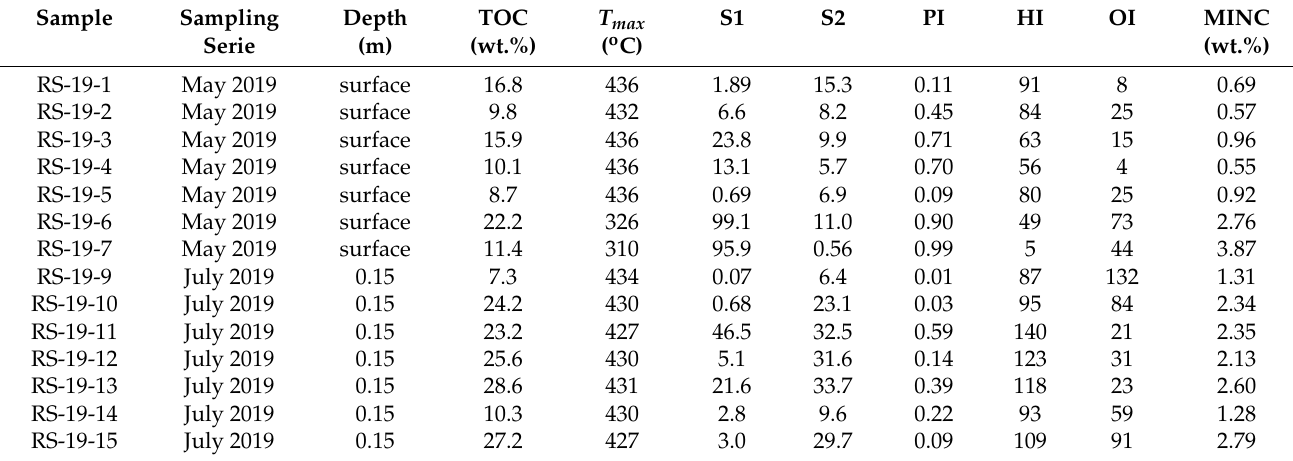
Table 4. Results of the Rock-Eval analysis (‘Bulk Rock’ method).